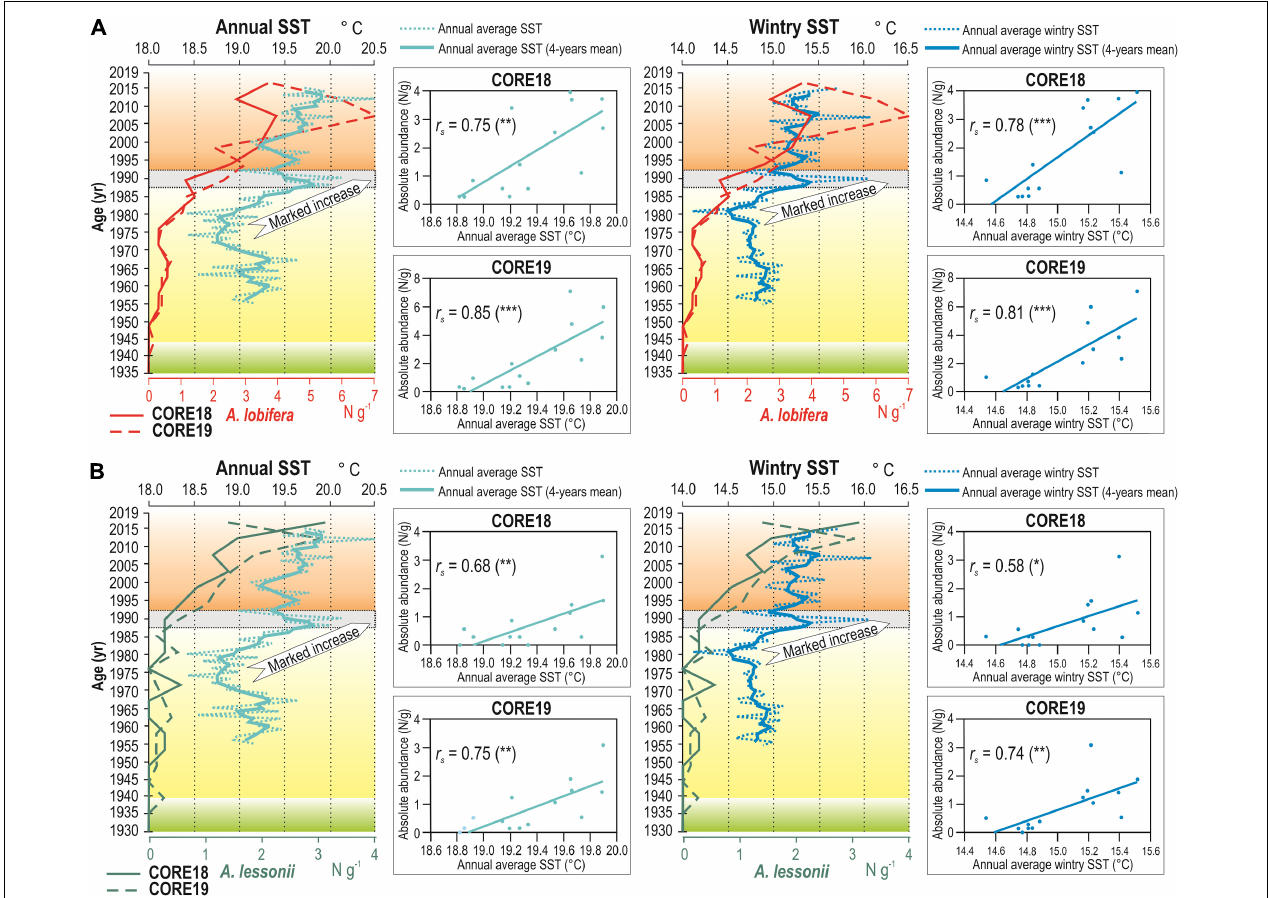
FIGURE 6 | Curves reporting from left to right: absolute abundance of A. lobifera (A) and A. lessonii (B) plotted against the annual SST and wintry SST simulated since 1955–2015. Beside: scatter-plots with Spearman’s coefficients ( r s ) relative to the absolute abundances of A. lobifera and A. lessonii recorded in CORE18 and CORE19 compared to the annual average and wintry SST ( p -values of correlation indicated in brackets as follows: * p < 0.05; ** p < 0.01; *** p <